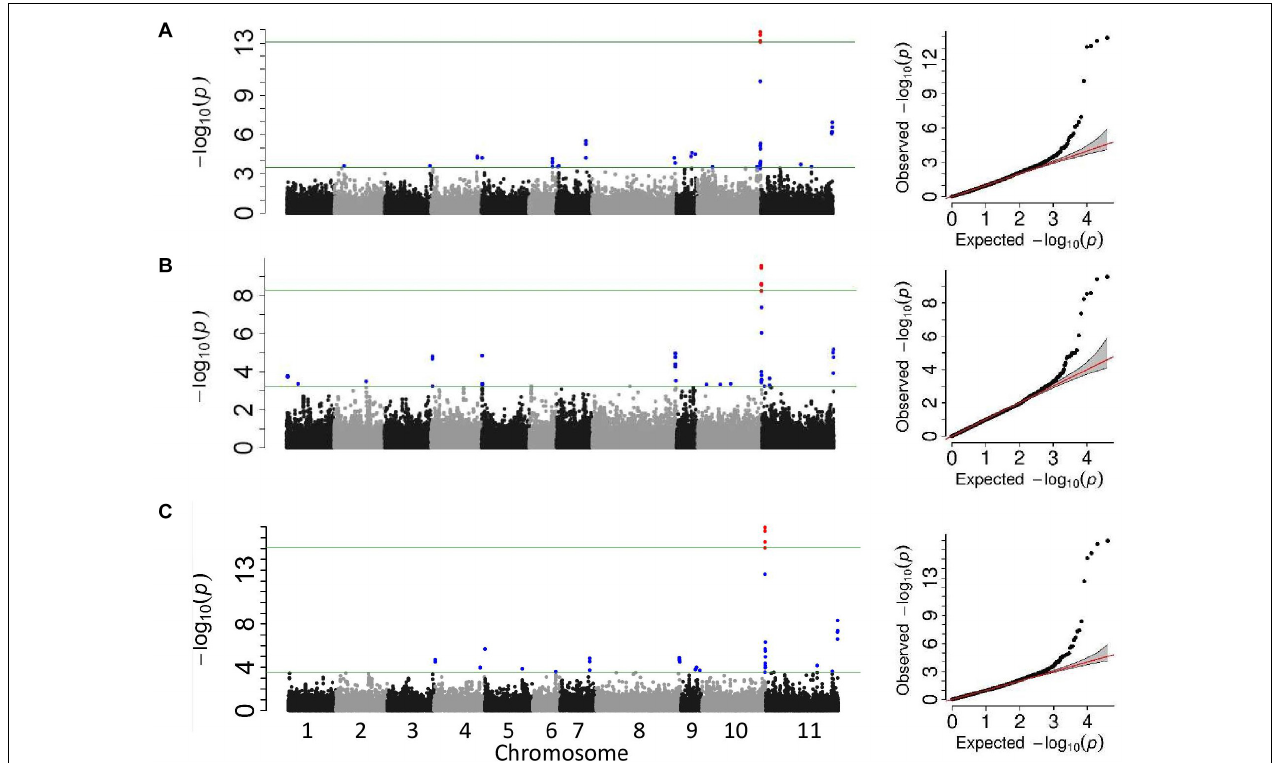
FIGURE 2 | Manhattan and QQ plots from the genome-wide association studies analyses of the Middle American breeding population. The upper horizontal bar represents the cutoff for the most 0.01% significant single-nucleotide polymorphisms (SNP) (depicted in red). The lower horizontal bar represents the cutoff for the 0.1% significant SNP (depicted in blue). Both cutoffs are based on 1,000 bootstraps of the empirical distribution of the p -values. (A) Univariate mixed model of the unifoliate phenotype, (B) univariate mixed model of the trifoliate phenotype, and (C) multi-variate mixed model of unifoliate and trifoliate